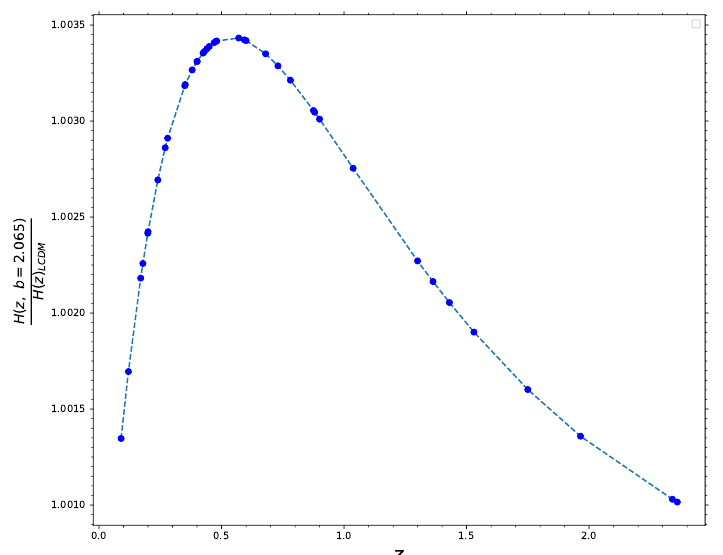
Figure 5. Plot showing the ratio between the Hubble parameter ( H ( z ) ) from our Swiss-cheese model computed at the best fit value of b = 2.065 and the Hubble parameter corresponding to the LCDM model for the redshift ranges of z =